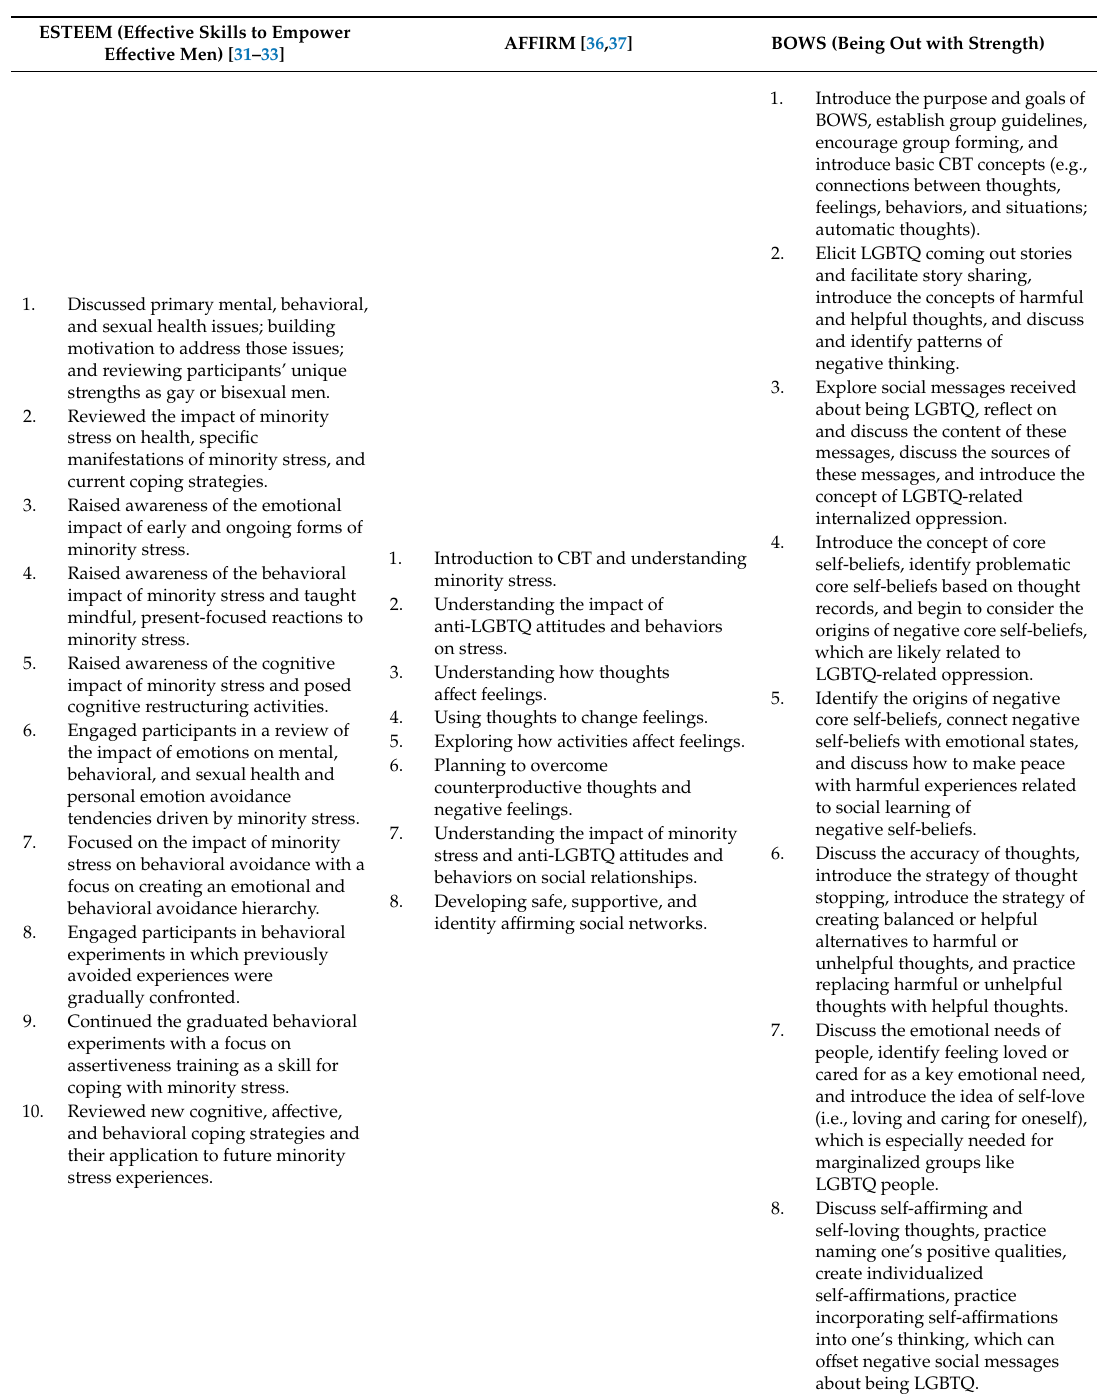
Table 1. Descriptions of sessions of CBT (cognitive behavioral therapy)-based interventions targeting depression among LGBTQ (lesbian, gay, bisexual, transgender, or queer) young people.